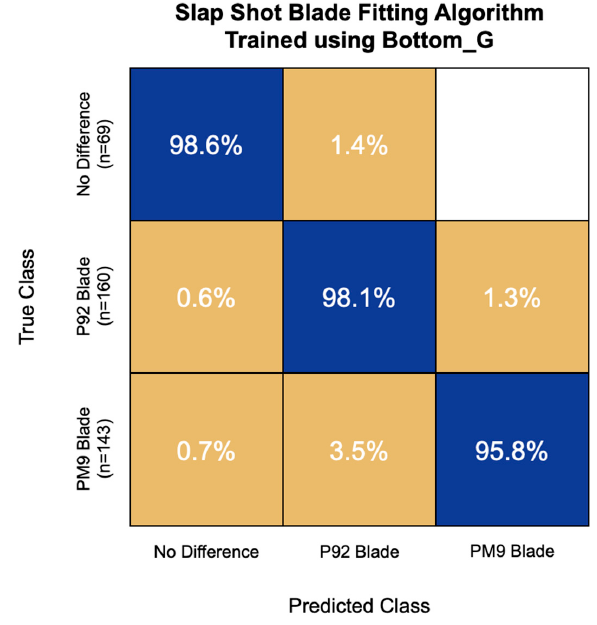
Figure 7. Confusion matrix of the blade fitting algorithm for slap shot speed trained using bottom hand resultant angular velocity (Bottom_G) signal features. Overall model accuracy was 97.3%.